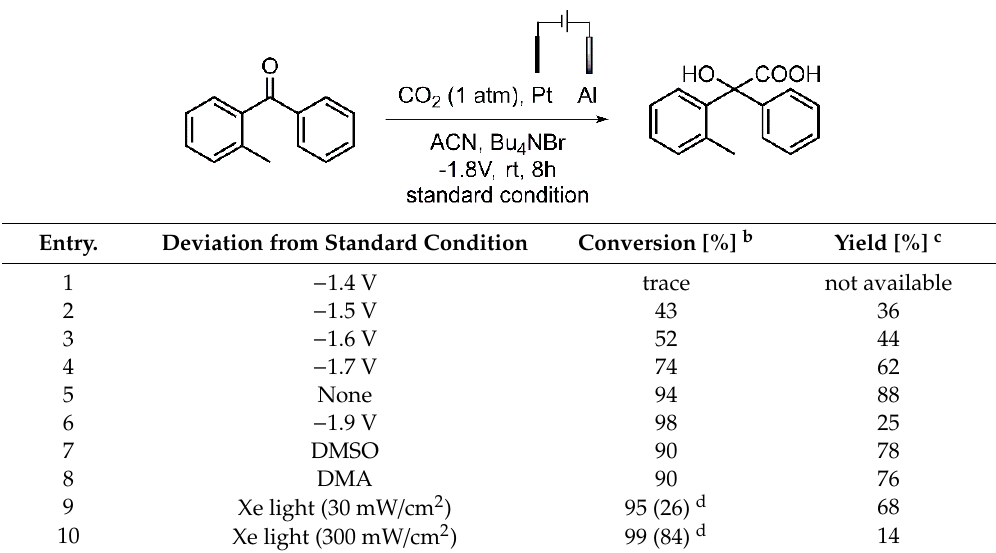
Table 2. Electro-carboxylation of o -methylbenzophenone with CO 2 a .